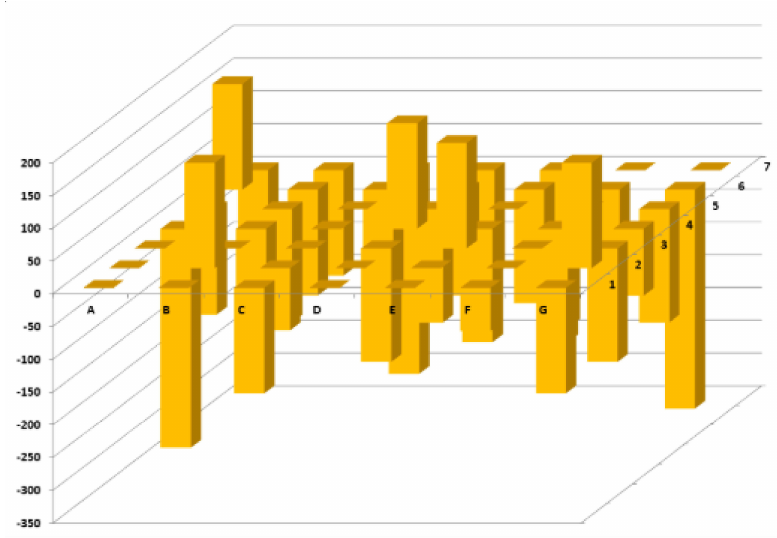
Figure 10. Graph of differences in measured velocities [m · s − 1 ] of ultrasound wave for specimen A2_2 before and after blast load of 350 g TNT.